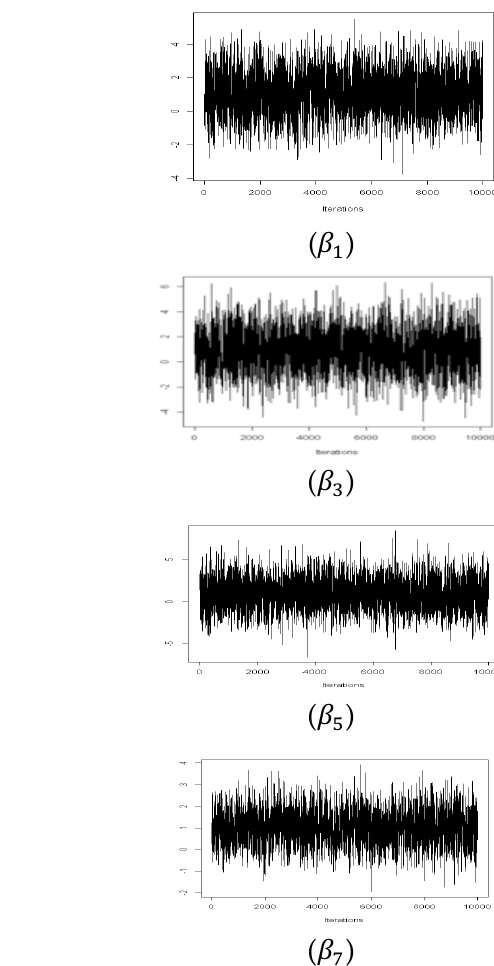
, …, (cid:2010) for the HBLD model. (cid:2868) (cid:2875)